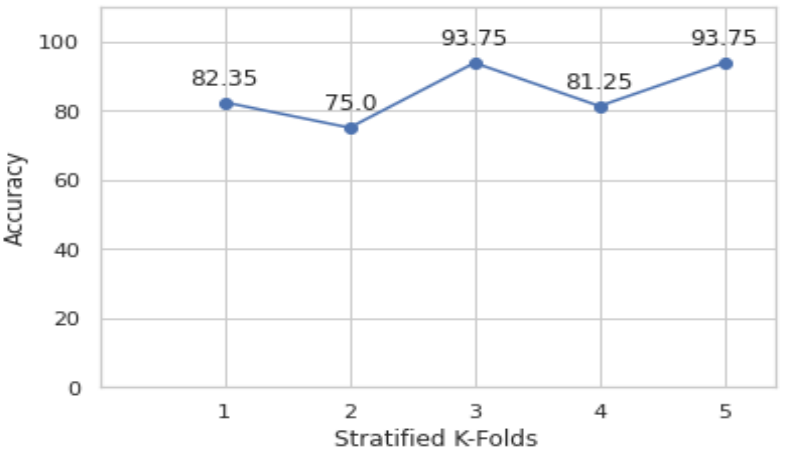
Figure 10. The classification accuracies of the KNN model using the stratified five-fold cross-validation. The classification accuracy of the KNN model using stratified five-fold cross-validation is shown in Figure 11. It demonstrates that the highest accuracy folds are 2, 4, 5, 6, 7, 9, and 10. The KNN model at the time was discovered to have a mean accuracy of 84.03% and an SD of 0.0535 that supported the 10-fold stratified cross-validation. The best parameters were determined to be n_Neighbor = 11 and p = 2, given Hyperparameter tuning by 10-fold stratified